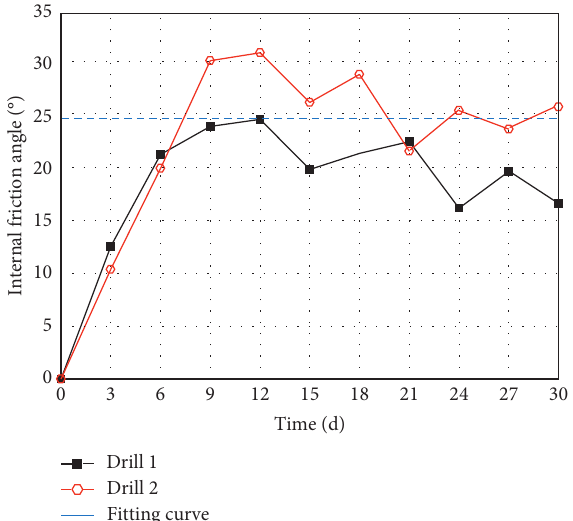
Figure 16: Trend of the internal friction angle with the curing